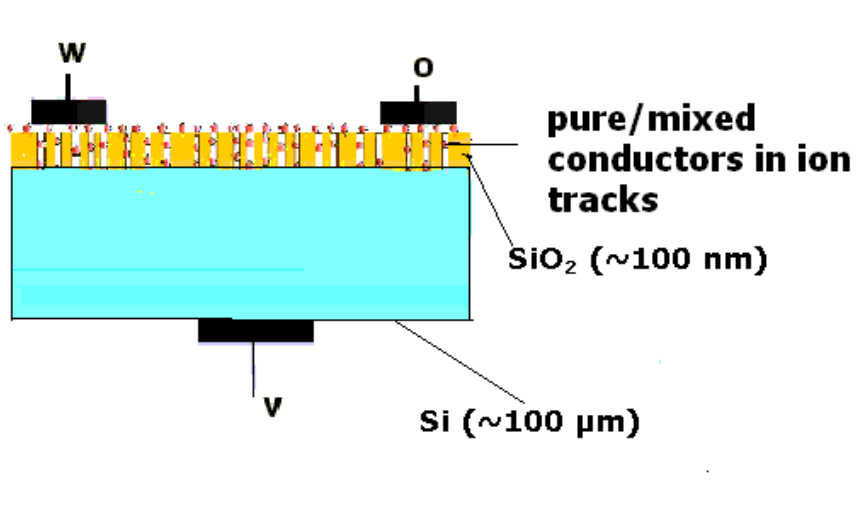
Figure 1. Schematic representation of a TEMPOS